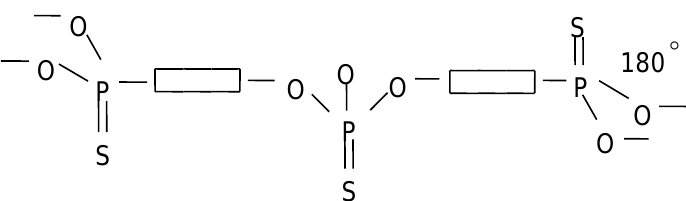
The spherical model of the molecule does not satisfy the experimental values of the dipole moments of dendrimers. The flat disk model is more suitable for explaining experimental data. The shape of the molecule depends on the orientation of the phenylenehydrazone fragments. The dipole moment of a dendrimer molecule depends on the parallel or antiparallel orientation of the polar groups (Figure 4).